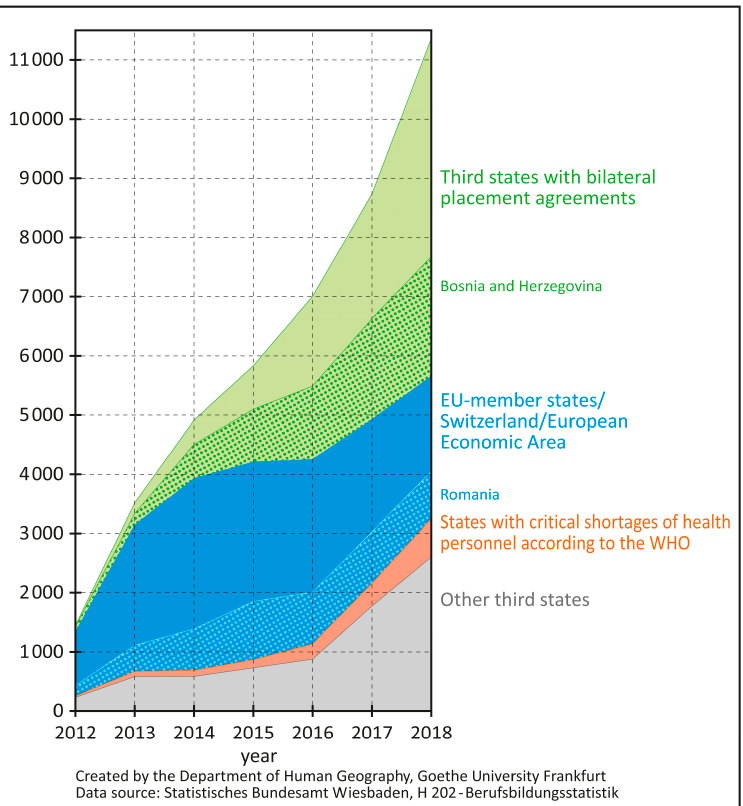
Figure 1. Number of new applications per year for recognition of credentials as registered nurse by region and selected states, 2012–2018.